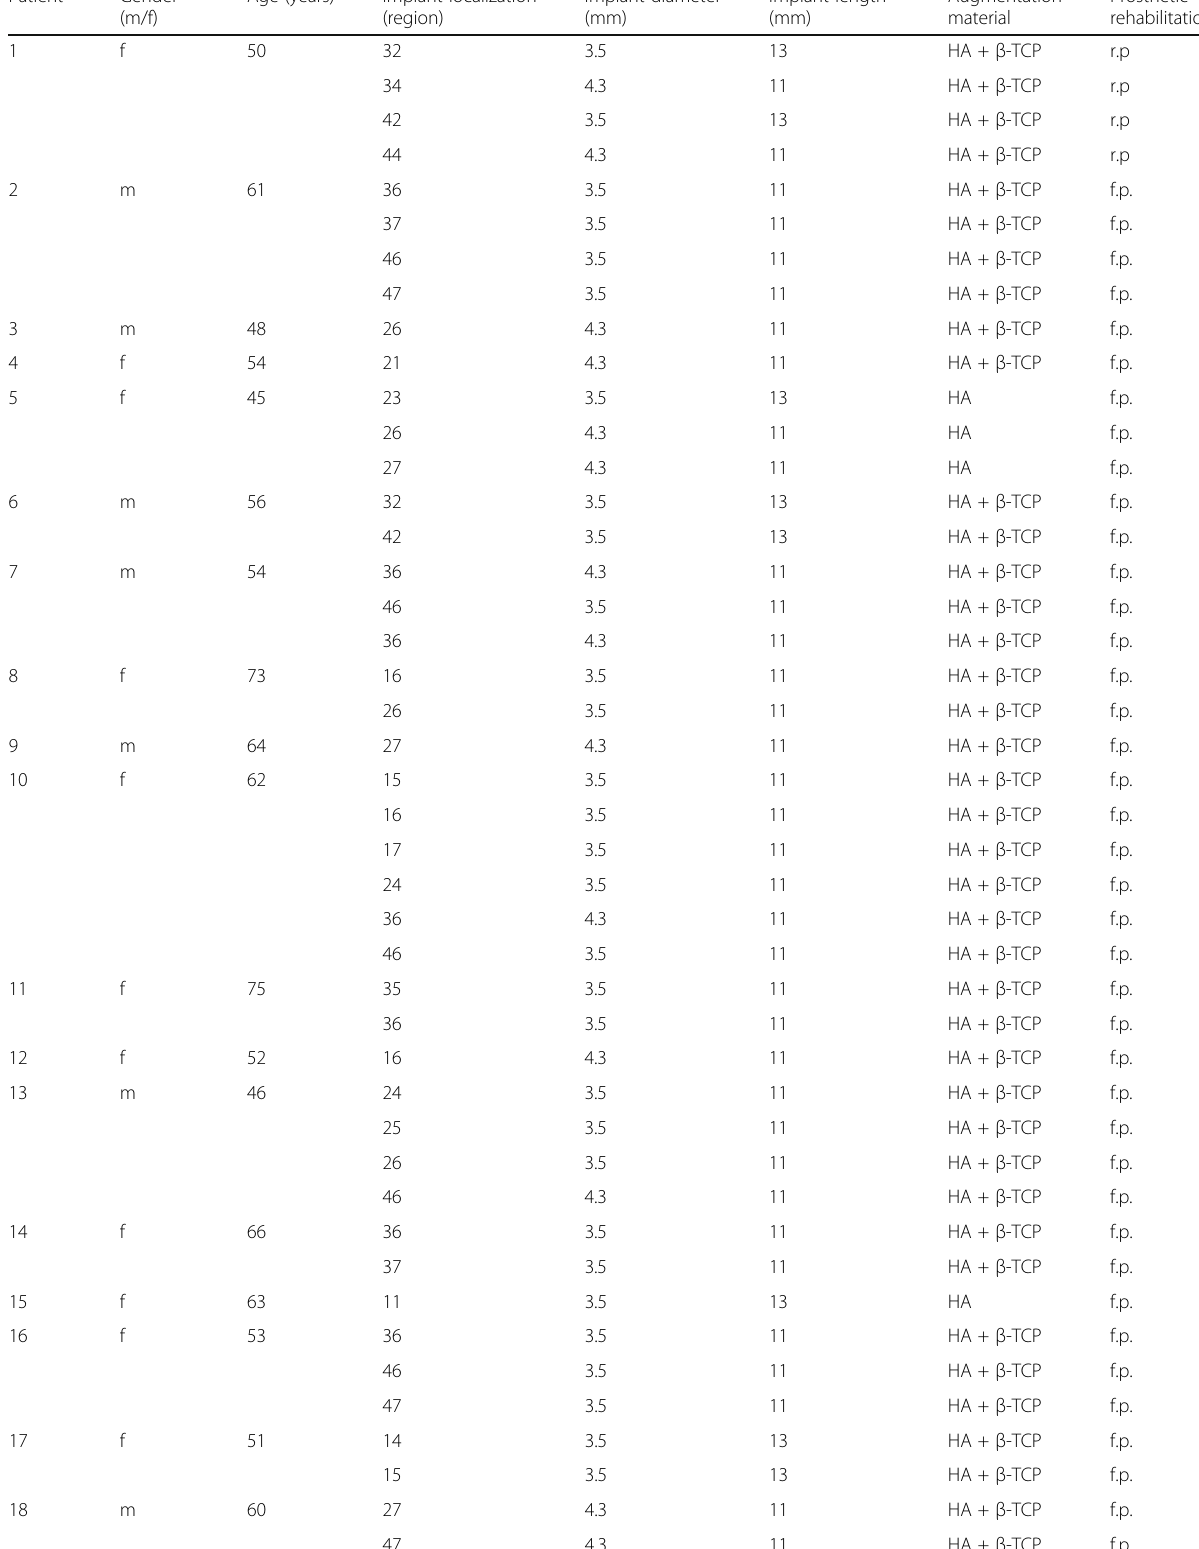
Table 1 Participating patients and the number and site of the inserted implants